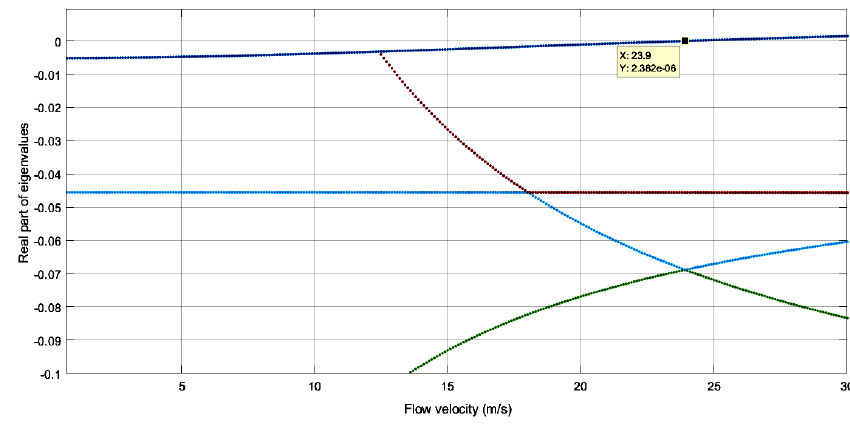
Figure 4. Flutter speed for control surface without freeplay.